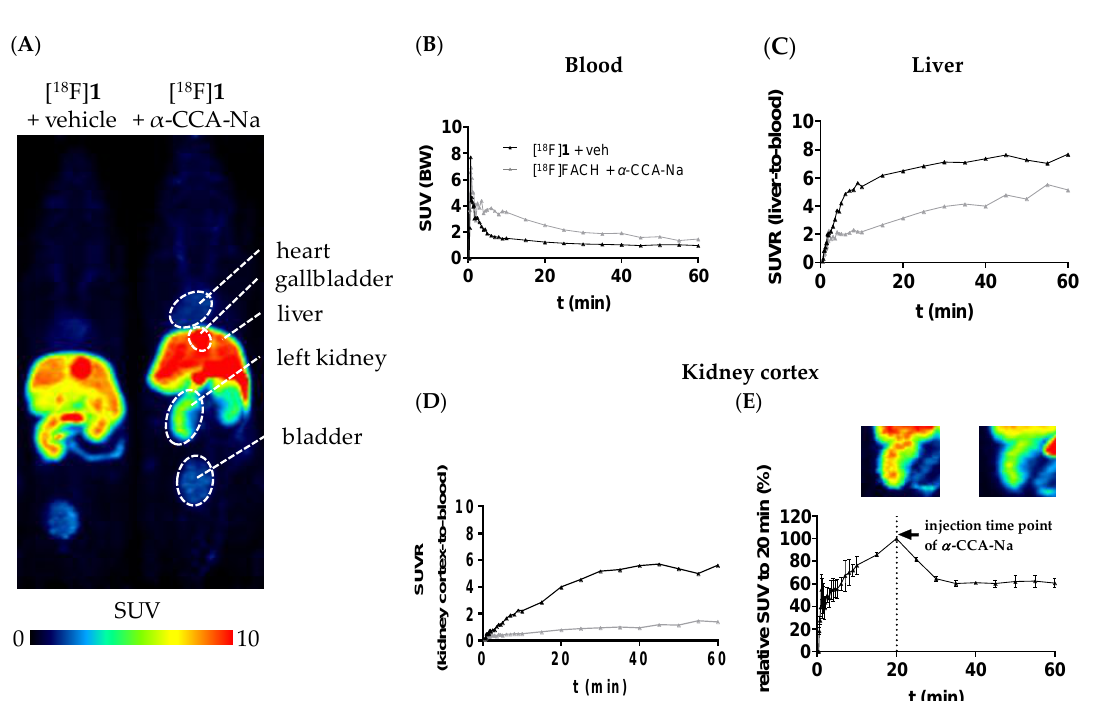
Figure 6. ( A ) Maximum intensity projections (MIPs) of small animal positron emission tomography (PET) images (45 – 60 min p.i., n = 1) of female CD-1 mice depicting the differential distribution of [ 18 F] 1 in peripheral organs without and with pre-administration of α -CCA-Na; ( B – D ) Time-activity curves representing the SUV of blood, as well as the standardized uptake value (SUV) ratio (SUVR) from liver-to-blood and kidney cortex-to-blood; ( E ) displacement study: i.v. application of α -CCA-Na 20 min after tracer injection (n = 2), MIPs of the left kidney (left: 15 – 20 min p.i. and right: 45 – 60 min p.i.).